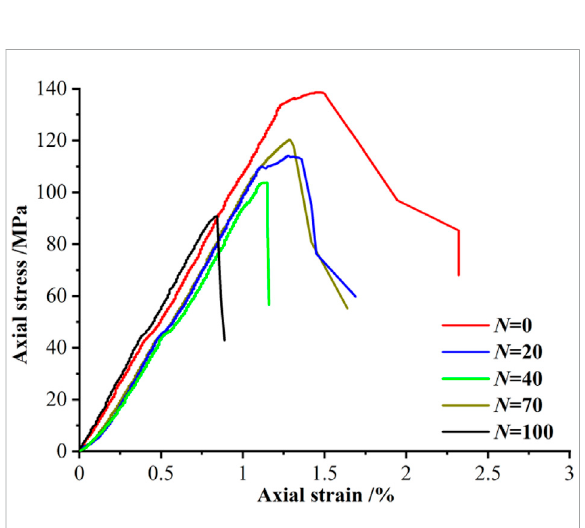
FIGURE 14 Axial stress-strain curves for granite under different numbers of F – T